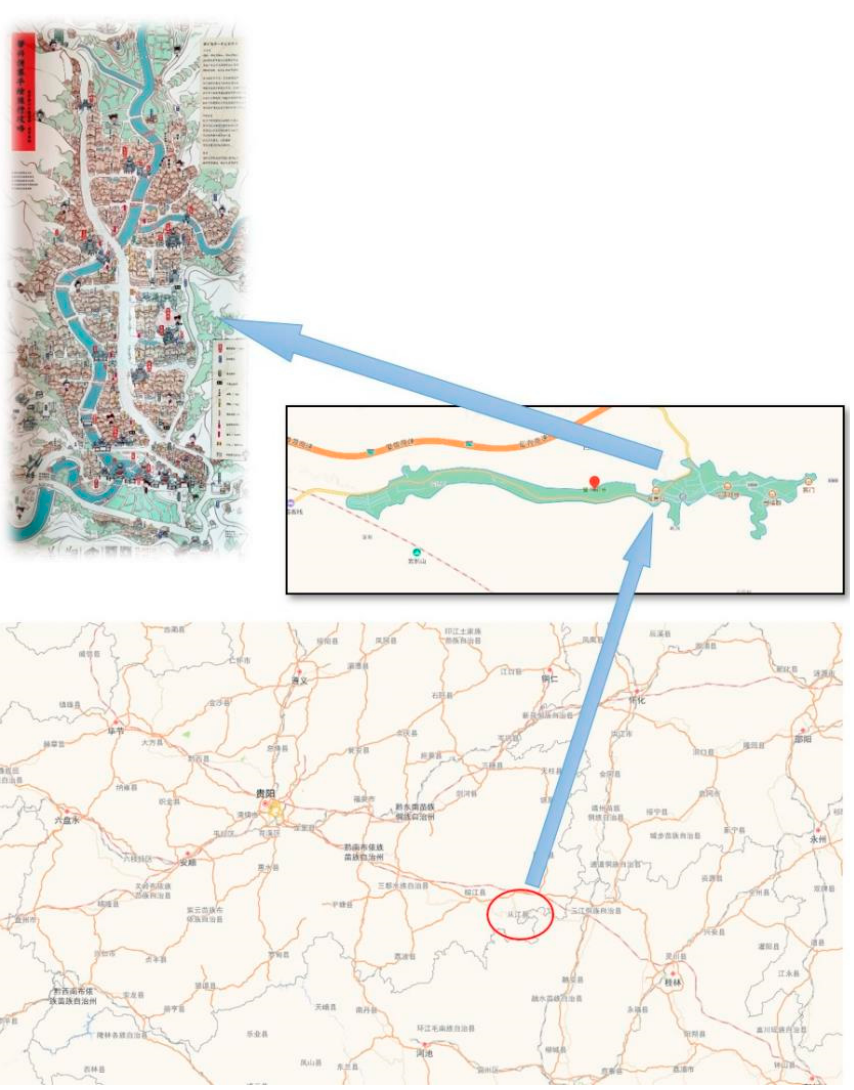
Figure 1. The location of Zhaoxing village.